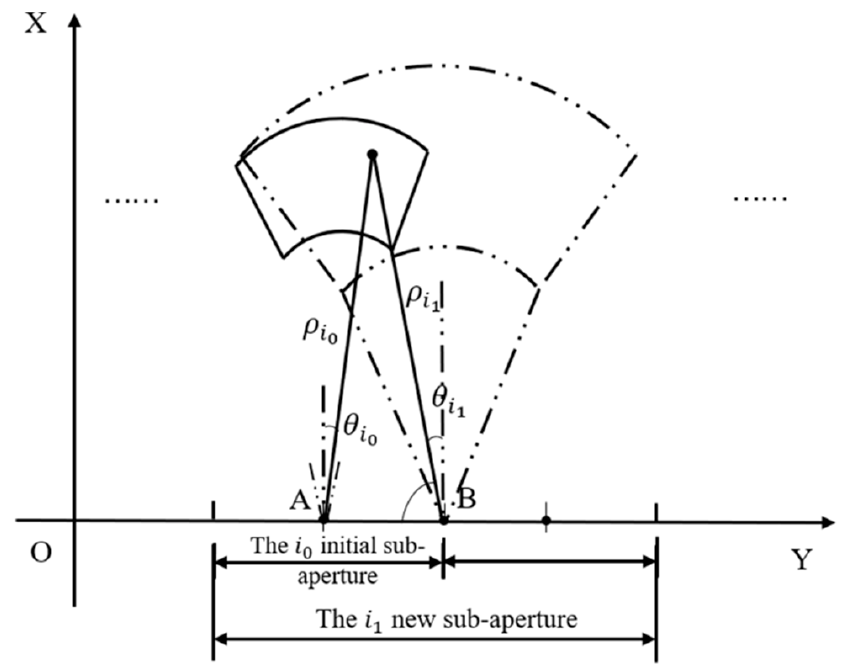
Figure 5. FFBP algorithm.